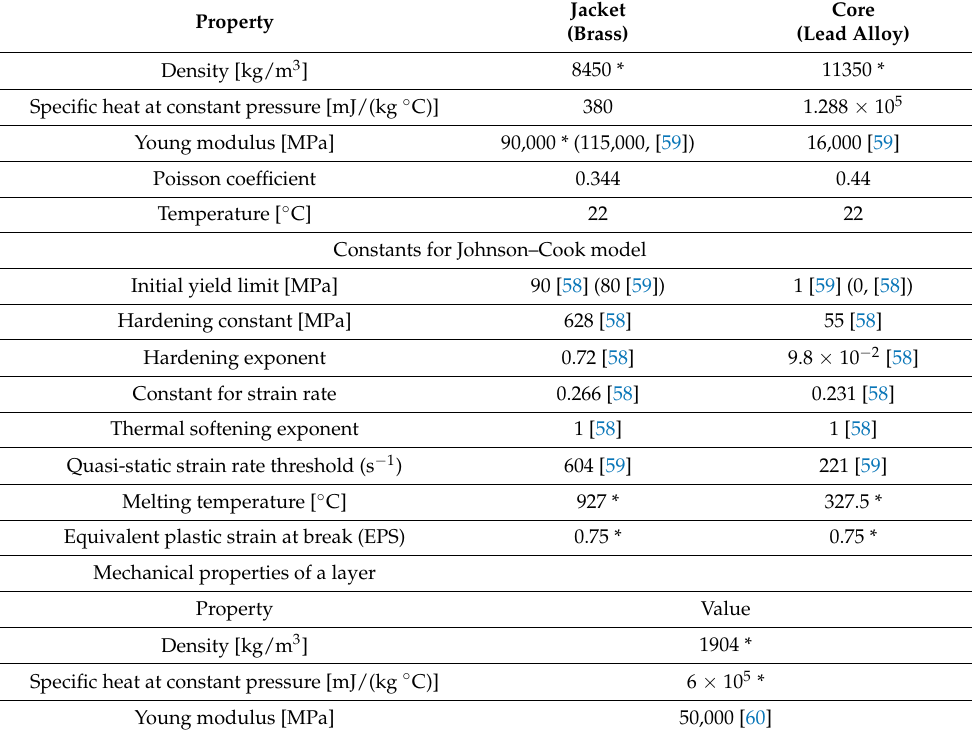
Table 6. Characteristics of materials involved in this